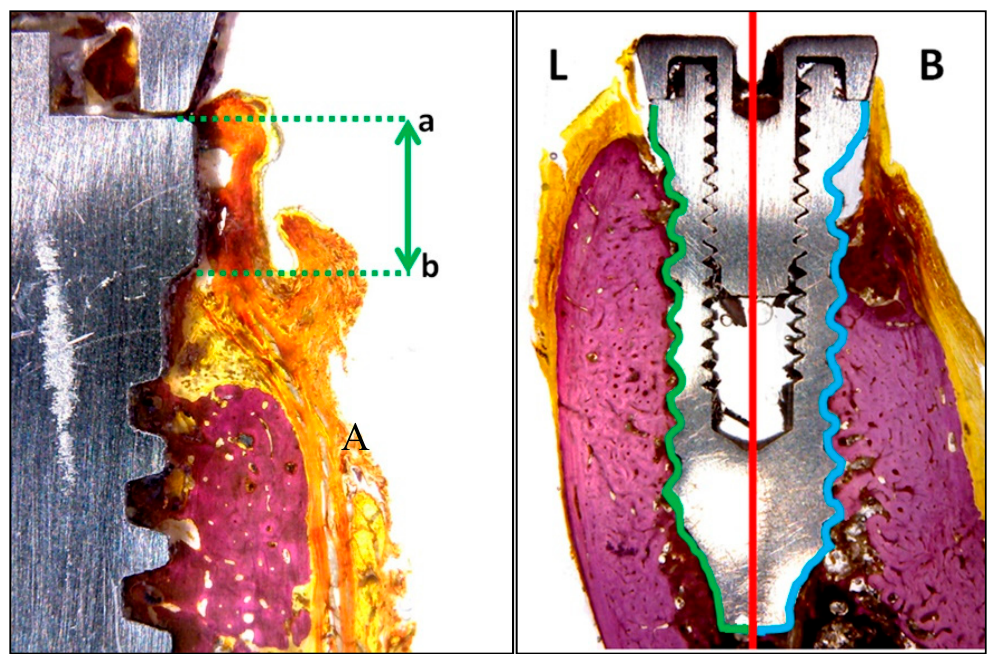
Figure 5. Schematic histological images showing measurement parameters: ( A ) crestal bone loss (CBL); (a) implant shoulder to (b) first point of bone contact. ( B ) Bone-to-implant contact (BIC)% measurement; in the lingual portion (L) the green line was considered, and in the buccal portion (B), the blue line was considered.